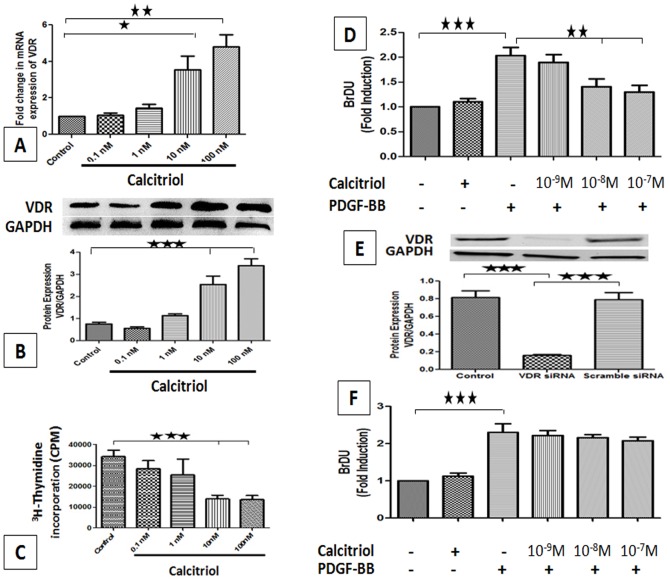
Effect of calcitriol stimulation on VDR mRNA transcript, VDR protein expression, cell proliferation in PCASMCs.Calcitriol-stimulated PCASMCs were subjected to RNA and protein isolation for qPCR (A) and Western blot (B) and data was normalized against GAPDH. Quiescent PCASMCs were incubated with calcitriol in SMCM with 10% FBS for 24 h followed by [3H] thymidine incorporation assay (C). Quiescent PCASMCs were stimulated with 20 ng/ml PDGF-BB with calcitriol for 24 h, and BrdU incorporation was analyzed (D). Representative Western blot and quantification of VDR protein in PCASMCs transfected with scrambled and VDR-specific siRNA (E). The relative expression of VDR protein was analyzed using GAPDH as a control. VDR knocked-down PCASMCs were stimulated with 20 ng/ml PDGF-BB with calcitriol for 24 h, and BrdU incorporation was analyzed (F). Data is mean± SEM (N = 3). *P<0.05, **P<0.01, ***P<0.001 all compared to control.